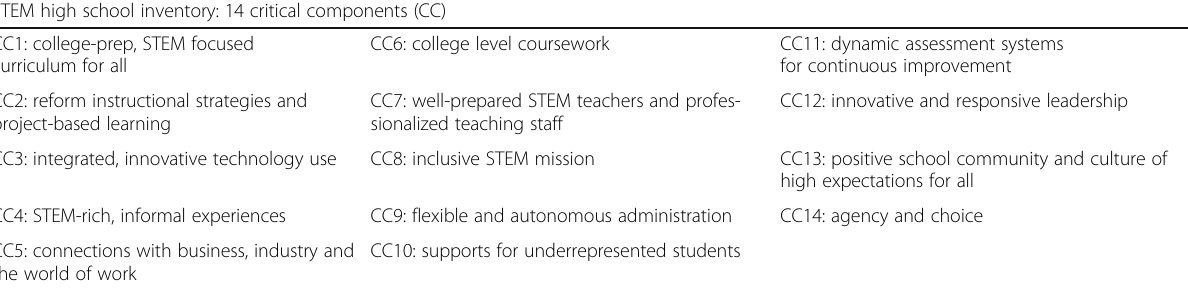
Table 2 The 14 critical components of an inclusive STEM high school STEM high school inventory: 14 critical components